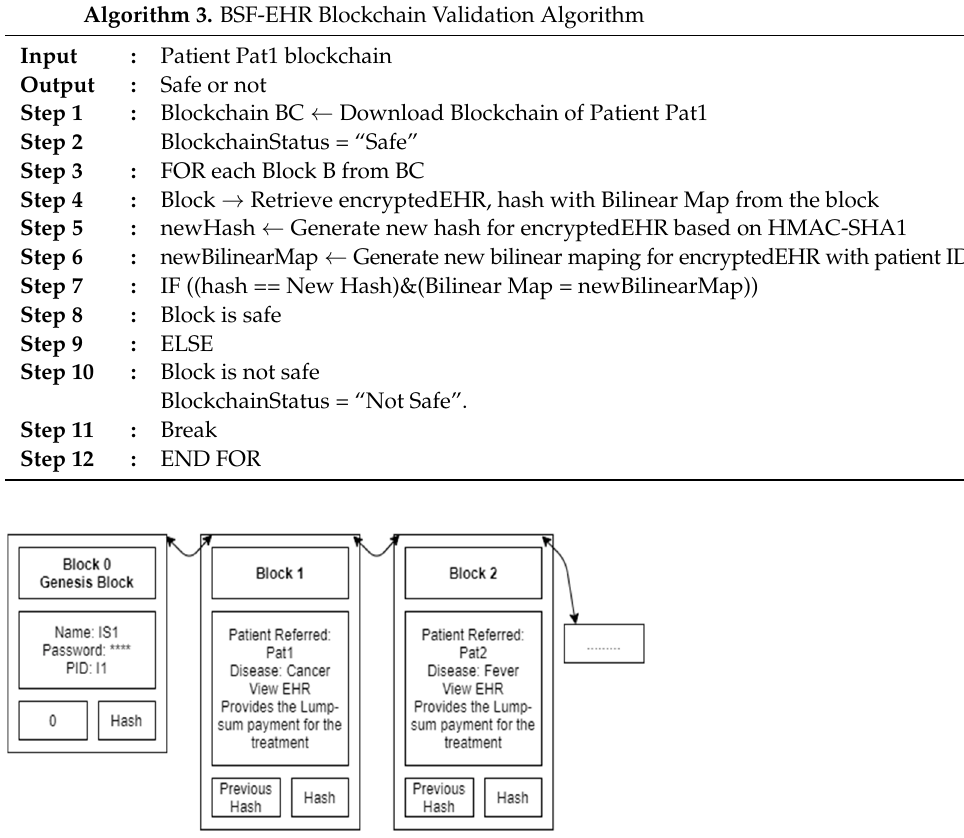
Figure 4. Insurance Agent IS1 blockchain. Algorithm 3 BSF-EHR Blockchain Validation Algorithm